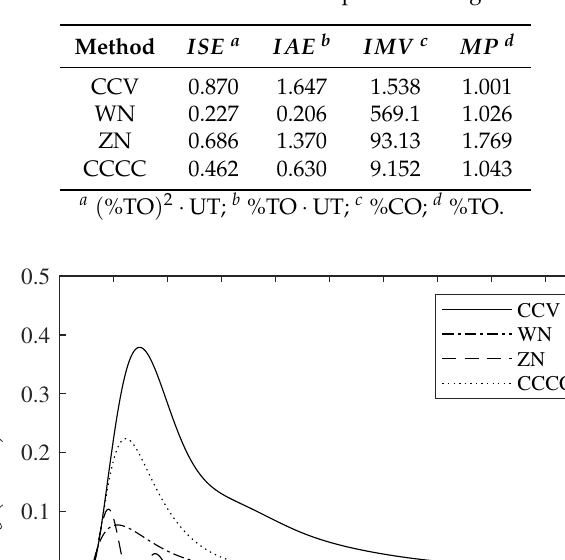
Table A13. Performance indexes. Set-point tracking for the set P 6 .